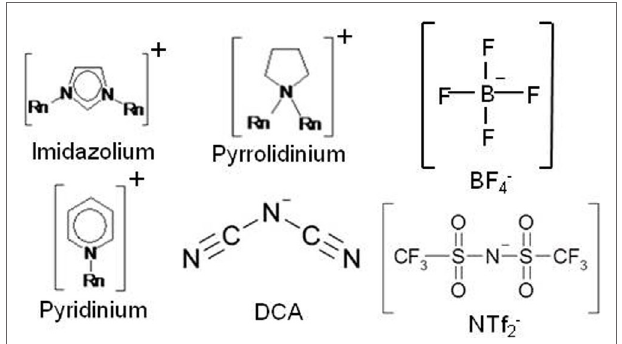
FiGUre 2 | structure of some common cations and anions in iLs